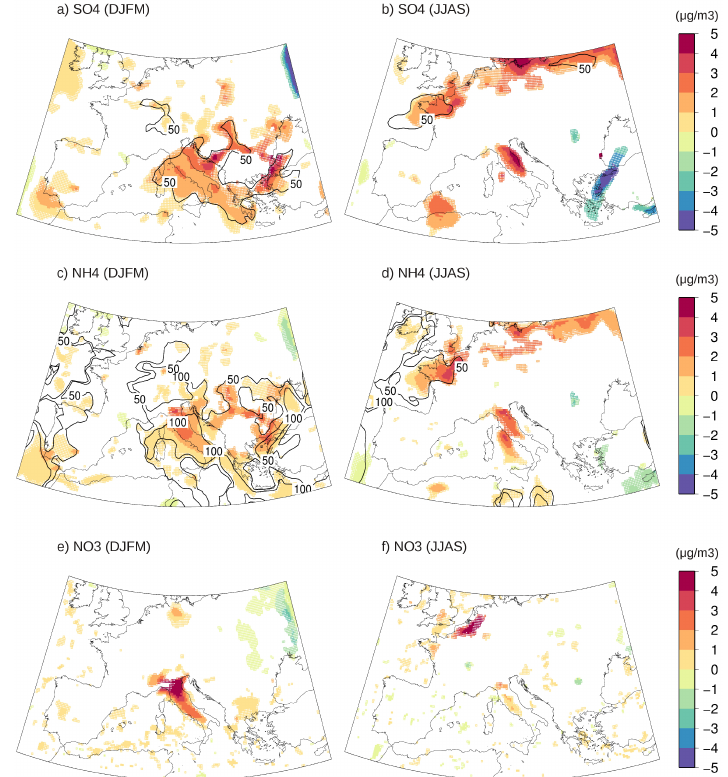
Fig. 6. As in Fig. 5, here for secondary inorganic aerosols: (a, b) SO 2 −